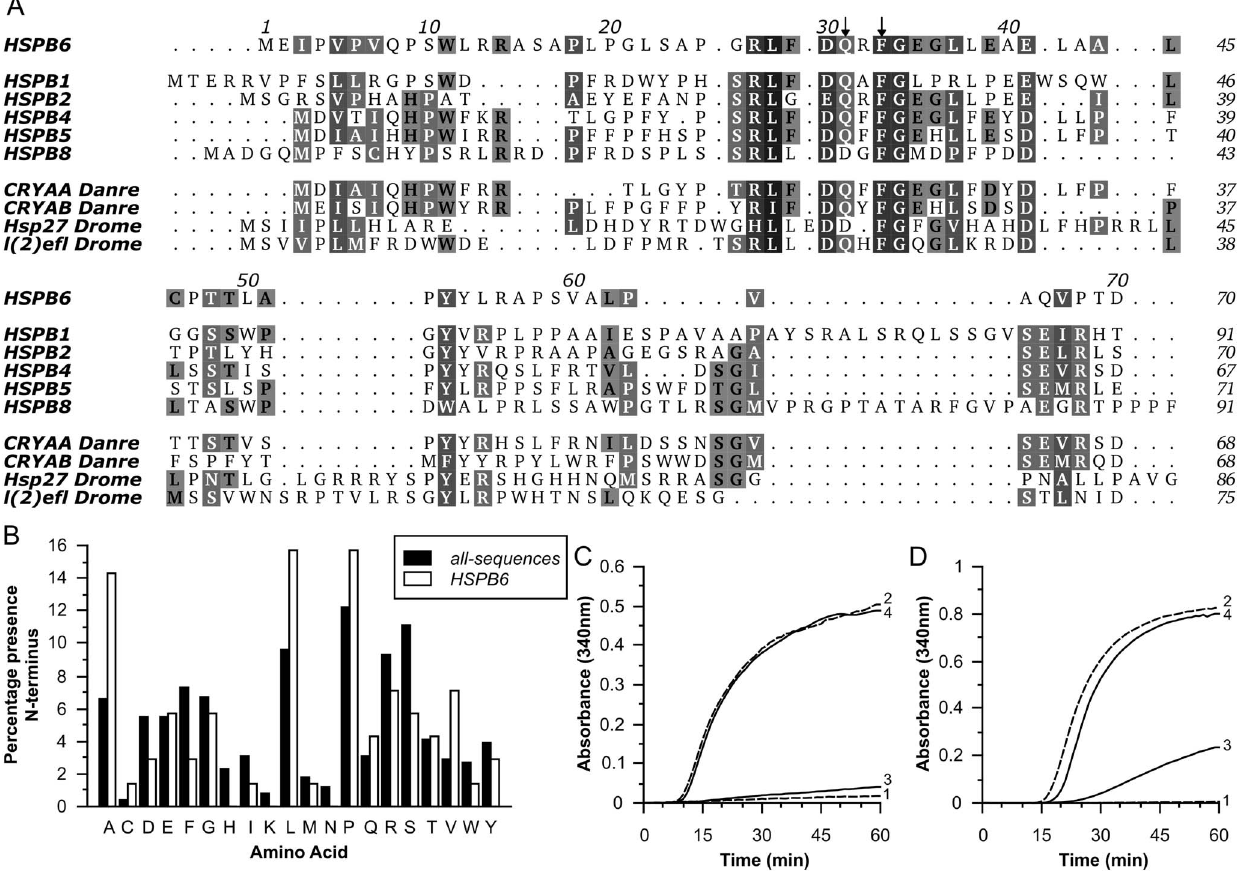
Figure 1. Properties of the N-terminal domain of HSPB6. (A) Multiple sequence alignment of the NTD of HSPB6 with other human sHSPs, the a -crystallins from Danio rerio (CRYAA and CRYAB) and two related proteins from Drosophila melanogaster (l(2)_efl and Hsp27). The two highly conserved residues that are mutated in this work are indicated by arrowheads. The alignment was made using Aline [54]. Uniprot accession numbers: HSPB1 (Hsp27): P04792, HSPB2: Q16082, HSPB4 (CRYAA): P02489, HSPB5 (CRYAB): P02511, HSPB6: O14558, HSPB8: Q9UJY1, CRYAA_Danre: Q8UUZ6, CRYAB_Danre: Q9PUR2, Hsp27_Drome: P02518, l(2)efl_Drome: P82147. (B) Amino acid composition within the N-terminus of HSPB1, HSPB2, HSPB4, HSPB5, HSPB6 and HSPB8 and orthologues in different species ( H. sapiens , B. taurus , M. musculus , X. leavis or tropicalis , G. gallus and D. rerio ). The average amino acid composition is shown as white bars, HSPB6 amino acid composition is shown as black bars. (C–D) Chaperone-like activity of human HSPB6 and the N-terminal deletion construct ( D N) using insulin (C) and yADH (D) as substrates. The monomer mass molar ratios of substrate:sHSP were 1:0.2 and 1:2 respectively, and were the same as used in further experiments. Curve 1, substrate alone; 2, substrate + DTT; 3, with addition of HSPB6; 4, with addition of D